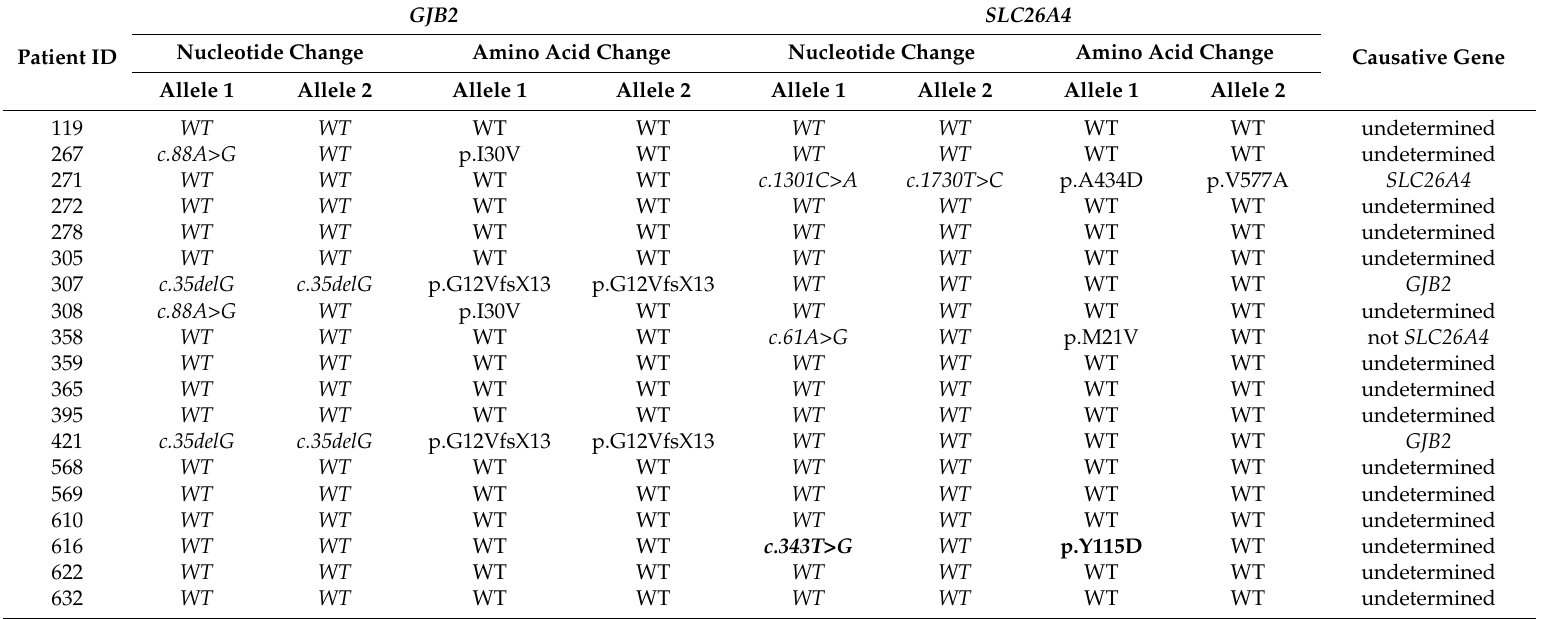
The novel pendrin sequence variant is indicated boldface. WT, wild